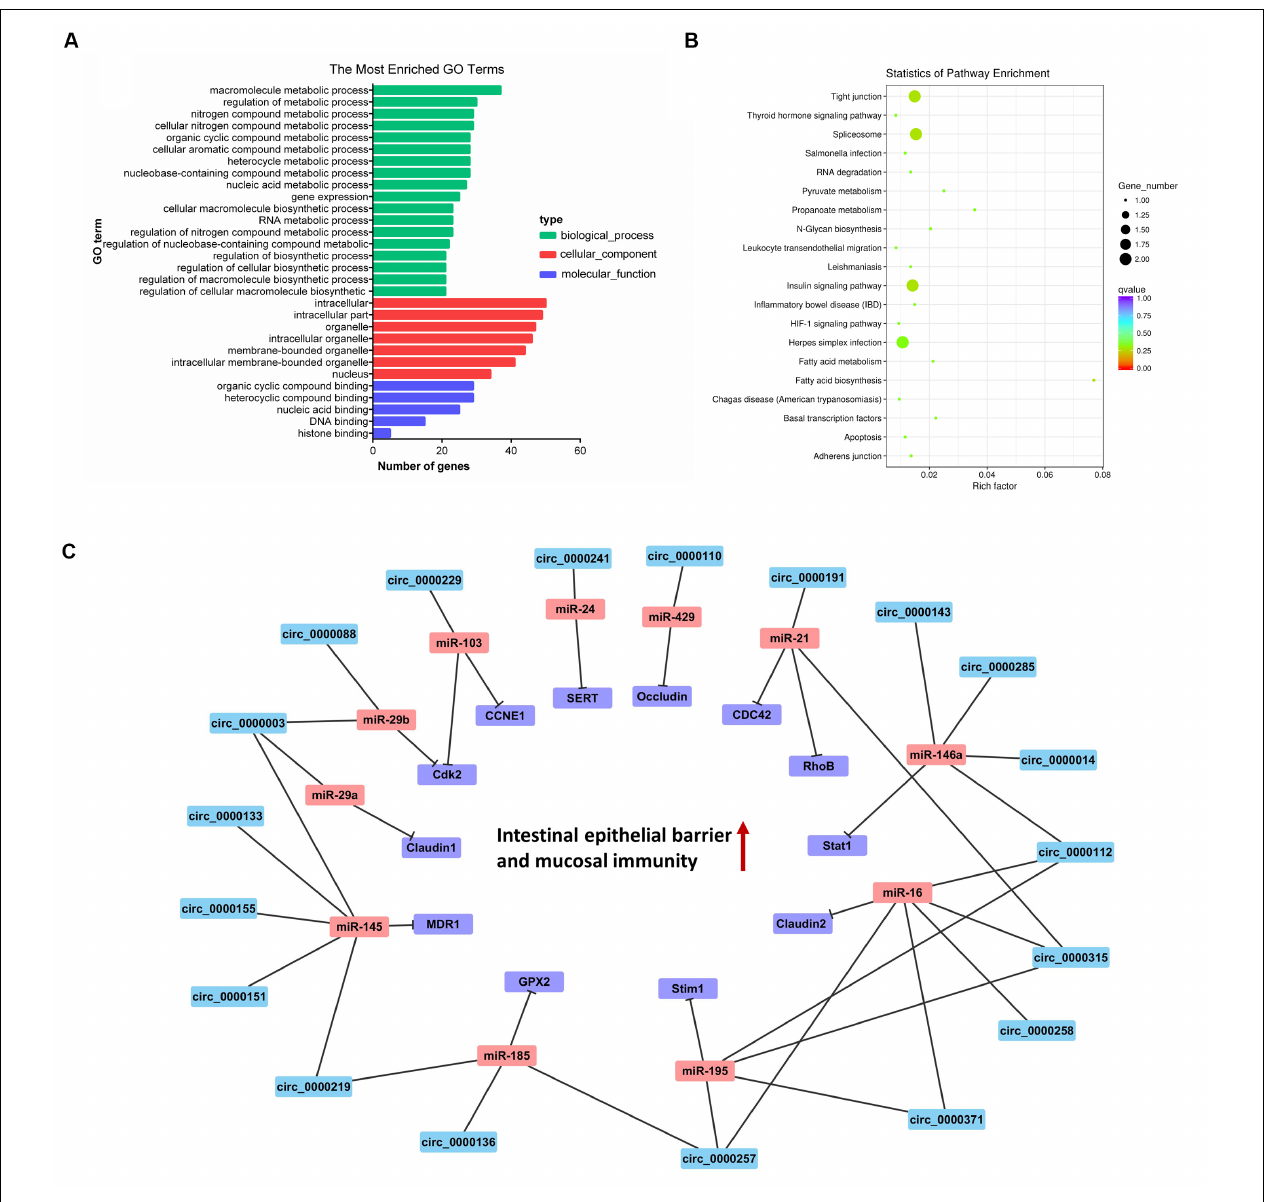
FIGURE 5 | Cluster analysis and enrichment analysis of porcine milk exosomes (PME) circRNAs. (A) Gene Ontology annotation analysis of host gene functions of PME circRNAs. (B) Kyoto Encyclopedia of Genes and Genomes enrichment analysis of host gene functions of PME circRNAs. (C) The circRNA–miRNA–mRNA correlation network targeted the intestinal barrier. The circRNAs are depicted in blue, the miRNAs in red, and the mRNAs in